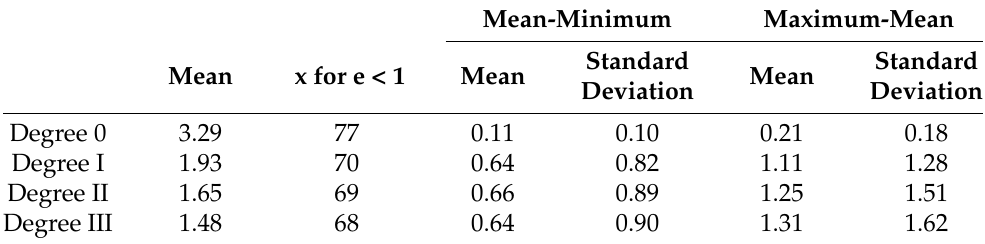
Table 1. Summary of results (men).